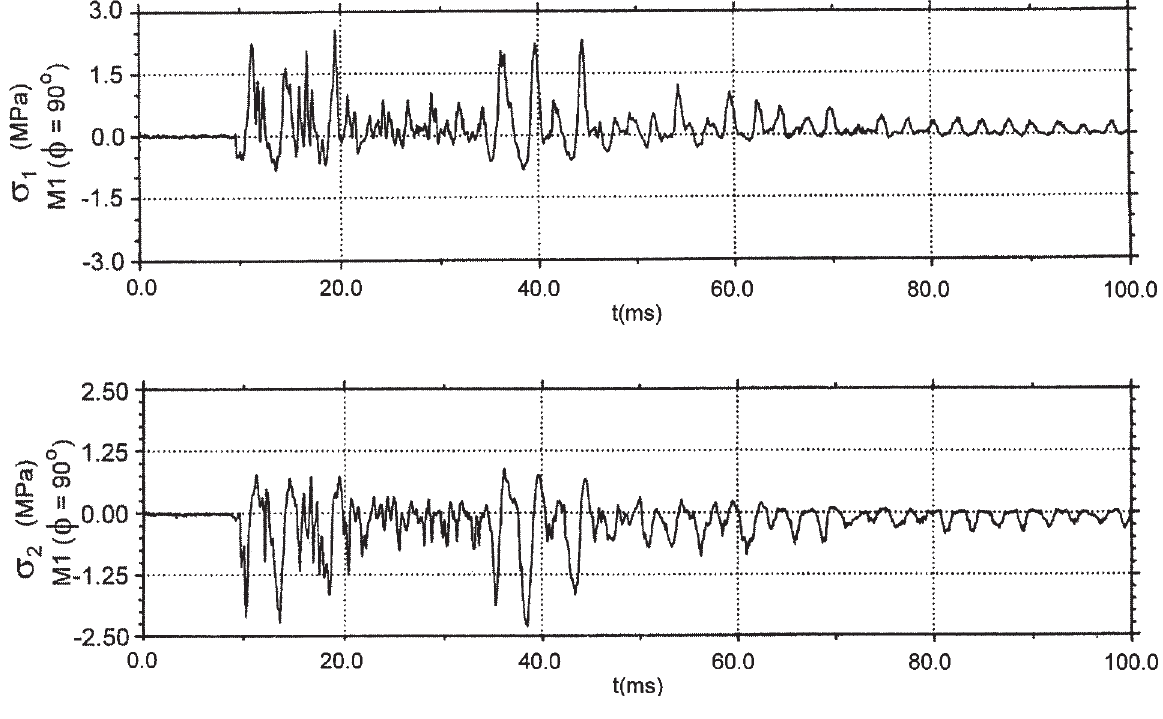
Fig. 12. Experimental principal stresses due to symmetric underwater explosive loading.